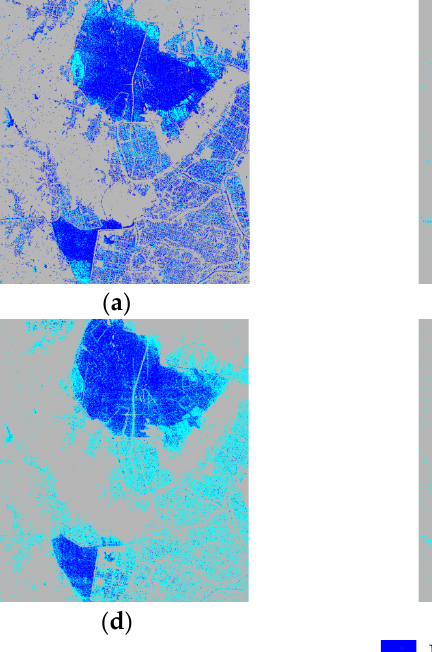
Figure 8. Feature classification map of Shijiu Lake. ( a ) HH polarization image water area extraction results; ( b ) HV polarization image water area extraction results; ( c ) VV polarization image water area extraction results; ( d ) SI water extraction results; ( e ) SI+GLCM water extraction results; ( f ) SI+SI_GLCM water extraction